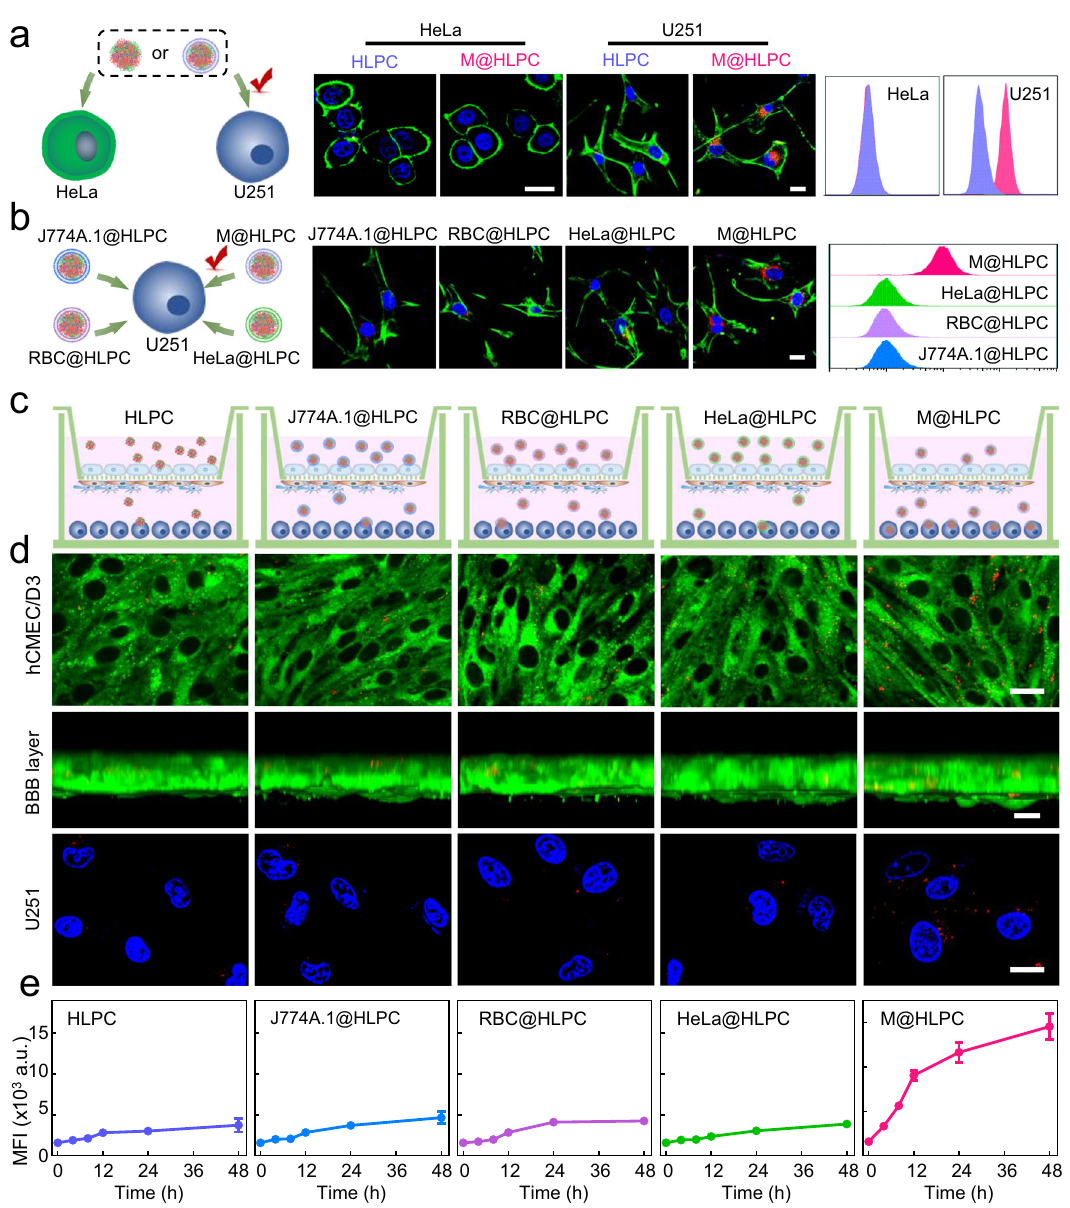
Fig. 4 In vitro homotypic tumor cell uptake and BBB penetration ability of M@HLPC. a Schematic illustration, representative CLSM images, and corresponding fl ow cytometry analysis in the experiment testing homotypic tumor cell uptake of nanoparticles (NPs). Human cervical carcinoma cells (HeLa) or human glioma cells (U251, the source of M used in the coating for the M@HLPC) were incubated with the same concentrations of bare HLPC or M@HLPC. Red: NPs (Ce6 signal); blue: Hoechst 33342-labeled nuclei; green: Rhodamine phalloidin-labeled HeLa or U251 cells. Scale bar: 25 μ m. b Schematic illustration, representative CLSM images, and corresponding fl ow cytometry analysis of an experiment examining the in fl uence of the M source on the glioma cell homing ability. HLPC were coated with M harvested from the diverse cell lines (macrophage J774A.1, red blood cells (RBC), HeLa, U251), and then incubated with U251 cells. Red: NPs (Ce6 signal); blue: Hoechst 33342-labeled nuclei; green: Rhodamine phalloidin-labeled U251 cells. Scale bar: 25 μ m. c Schematic illustration of the in vitro BBB model (Transwell ™ ) for evaluating the potential BBB penetration ability of the bare HLPC and those coated with diverse M. d Representative CLSM images of the hCMEC/D3 monolayer, BBB layer, and U251 cells showed the penetration and targeting ability of various NPs. Red: NPs; blue: Hoechst 33342-labeled nuclei; green: DIO-labeled BBB layer cell membrane. Scale bar: 25 μ m. e Quanti fi cation analysis of time-dependent internalization of NPs by U251 cells. Data in e were presented as the mean ± SD, n = 3 independent samples. The experiments in ( a , b , d ) were repeated independently three times with similar results. Source data are provided in the Source data fi speci fi c recognition between coated U251 cell membrane and upper chamber. CLSM of hCMEC/D3 and the corresponding hCMEC/D3 cells (Supplementary Fig. 9). In the lower chamber, BBB layer imaging showed that the M@HLPC samples had the time-dependent quanti fi cation data also showed that M@HLPC strongest fl uorescence signals in the human brain endothelial cells exhibited the highest uptake ef fi ciency by U251 cells (Fig. 4e). in the upper chamber rather than in groups of uncoated HLPC or Taking 48 h as an example, the intracellular M@HLPC yielded at those coated with non-glioma cell membrane materials (Fig. 4d), least 3.1-fold compared to that of other NPs. These in vitro which should be attributed to the transcytosis sourced from the